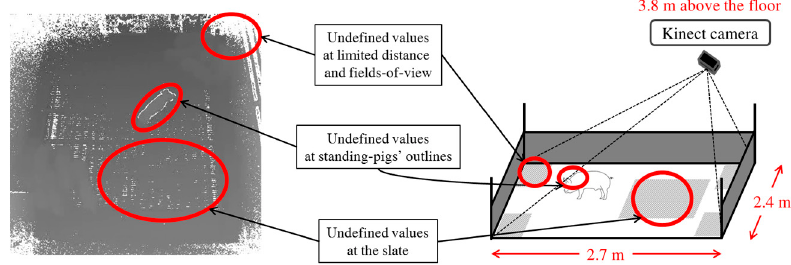
Figure 1. Undefined values caused by various factors in the monitoring environment in a commercial farm.